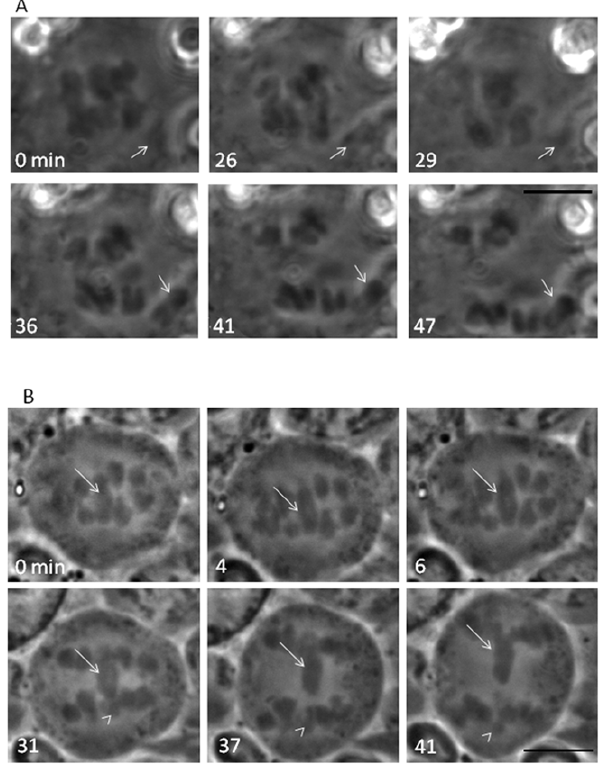
Figure 2. Metaphase I-Anaphase I in living Physocyclus mex- icanus and Holocnemuspluchei spermatocytes. A. Progression from metaphase I (0, 26, 29 min.) through anaphase I (36, 41, 47 min.) in Physocyclus mexicanus . A univalent chromosome remains near one spindle pole (arrow) through metaphase I and anaphase I. Bar=10 m m. B. Progression from metaphase I (0, 4, 6 min.) through anaphase I (31, 37, 41 min.) in Holocnemus pluchei . X (arrow) and Y (arrowhead) chromosomes are located in the center of the spindle in metaphase (0, 4, 6 min.) and X and Y chromosomes separate from one another in anaphase (31, 37, 41 min.). Bar=10 m